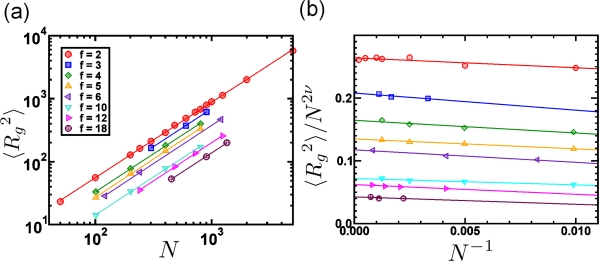
(a) Log-Log plot of 〈Rg2〉 vs. N of star polymers with different arm numbers f. For comparison, data for linear chains (f = 2) are displayed as well. (b) Scaling plot of the corrections to scaling of 〈Rg2〉 (f) plotted vs. N−1 in good solvent. For clarity, the smallest data point of the linear chains (f = 2, N = 50) is not displayed.